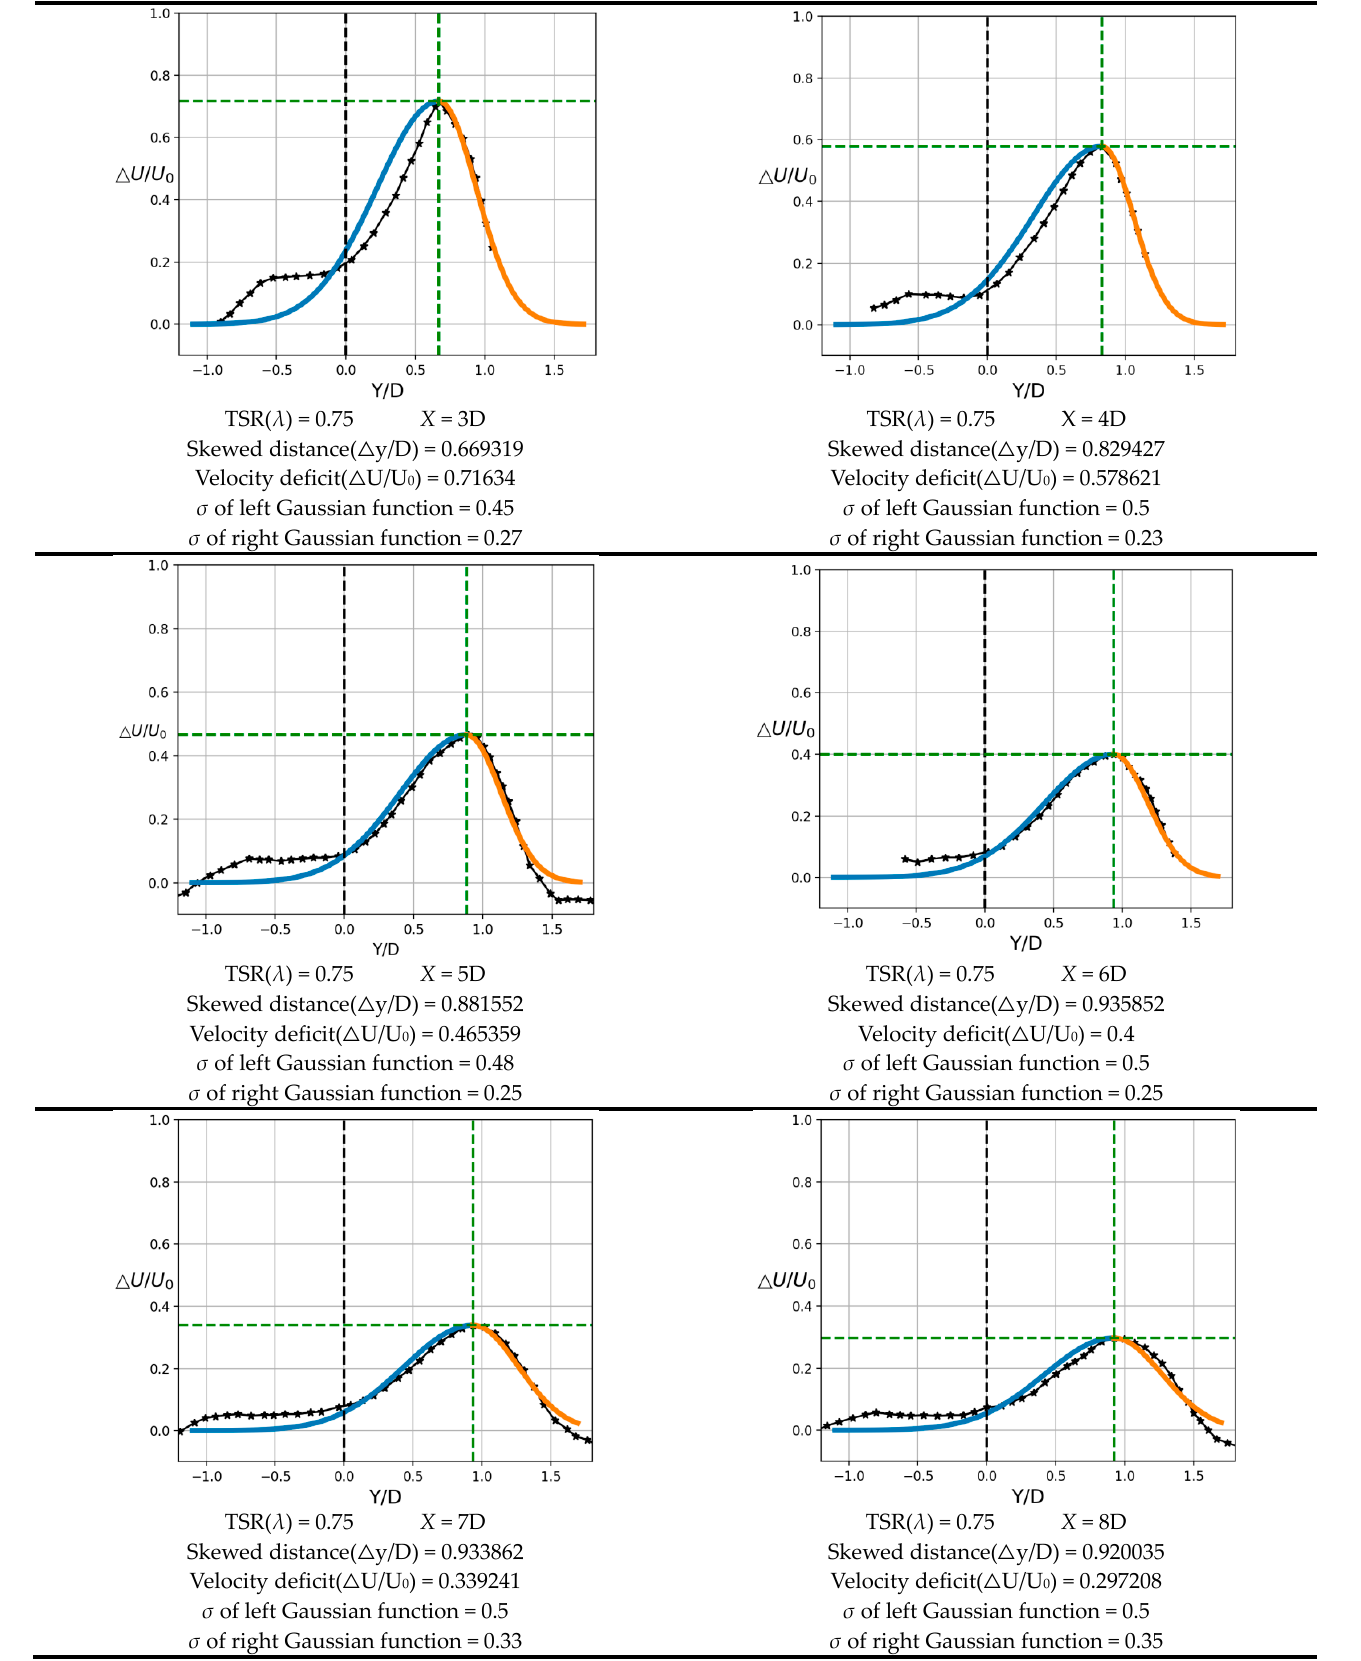
Skewed distance( △ y/D) = 0.920035 Velocity deficit( △ U/U 0 ) = 0.297208 σ of left Gaussian function = 0.5 σ of right Gaussian function =